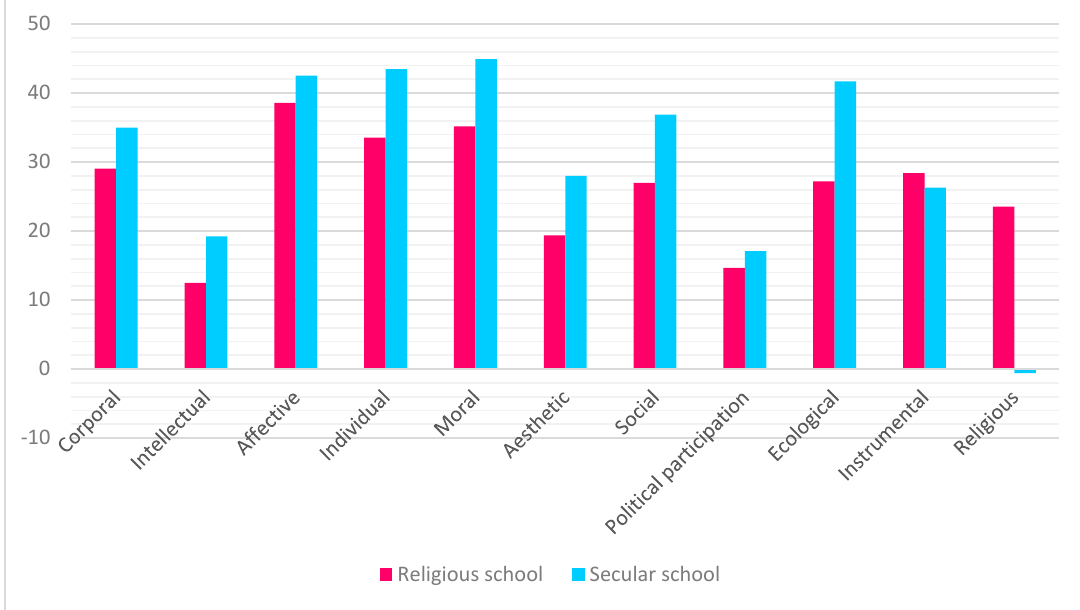
Figure 1. Comparison of the hierarchy of values between the religious schools and secular schools.